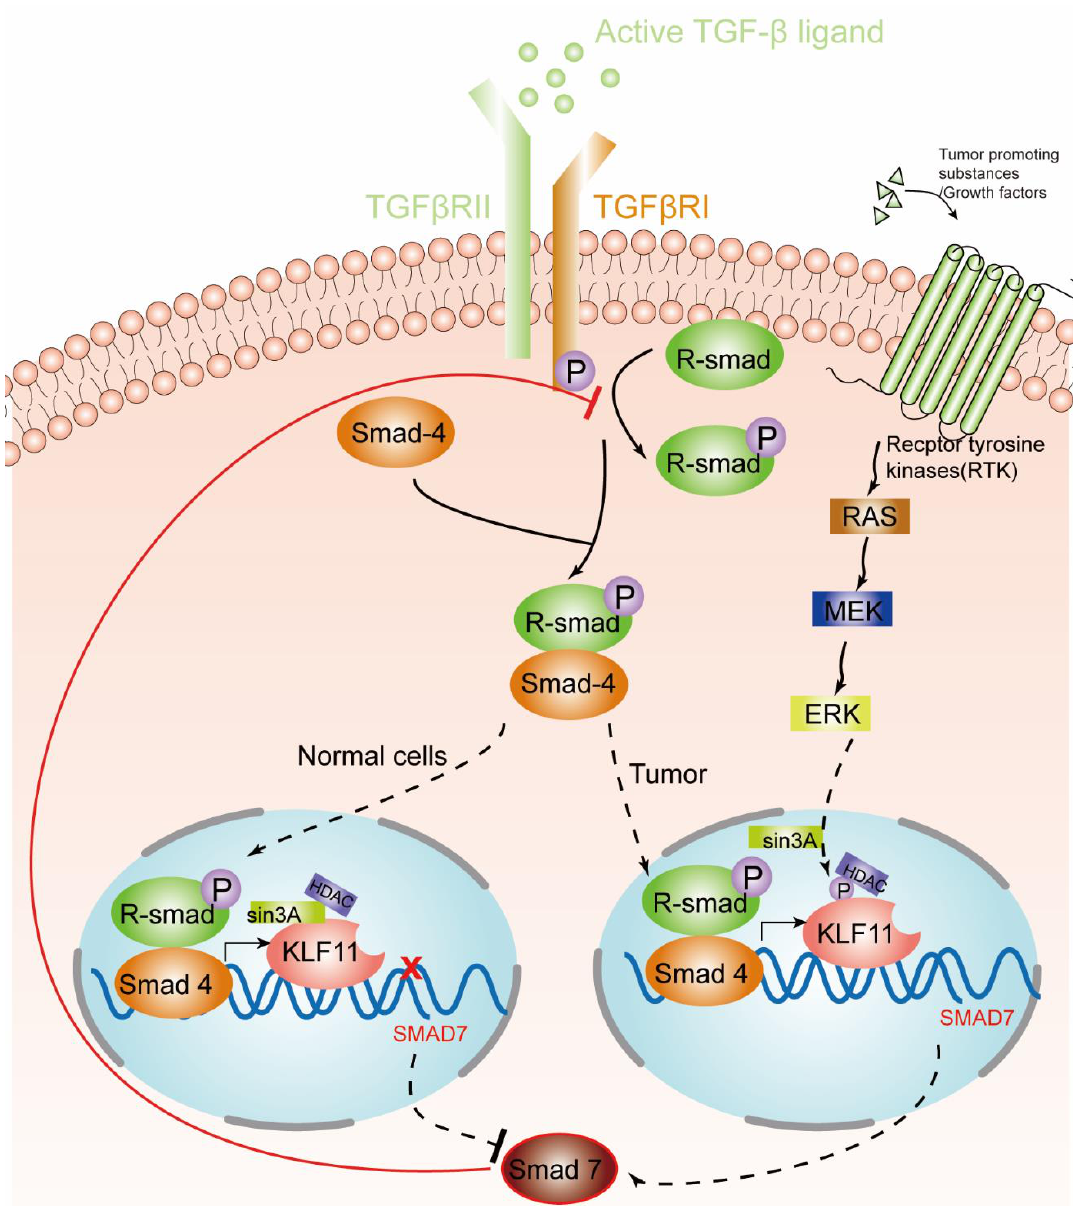
Figure 1. KLF11-mediated modulation of the TGF-β signaling pathway in normal cells and